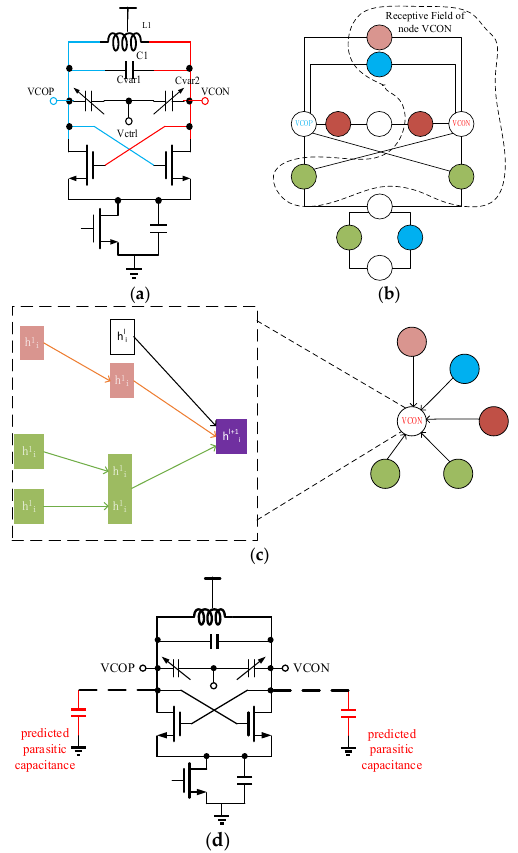
Figure 1. GNN-Based parasitic prediction. ( a ) Pre-layout schematics; ( b ) Graph embedding; ( c ) Mes- sage passing and Node aggregation; ( d ) Schematics with predicted parasitics.